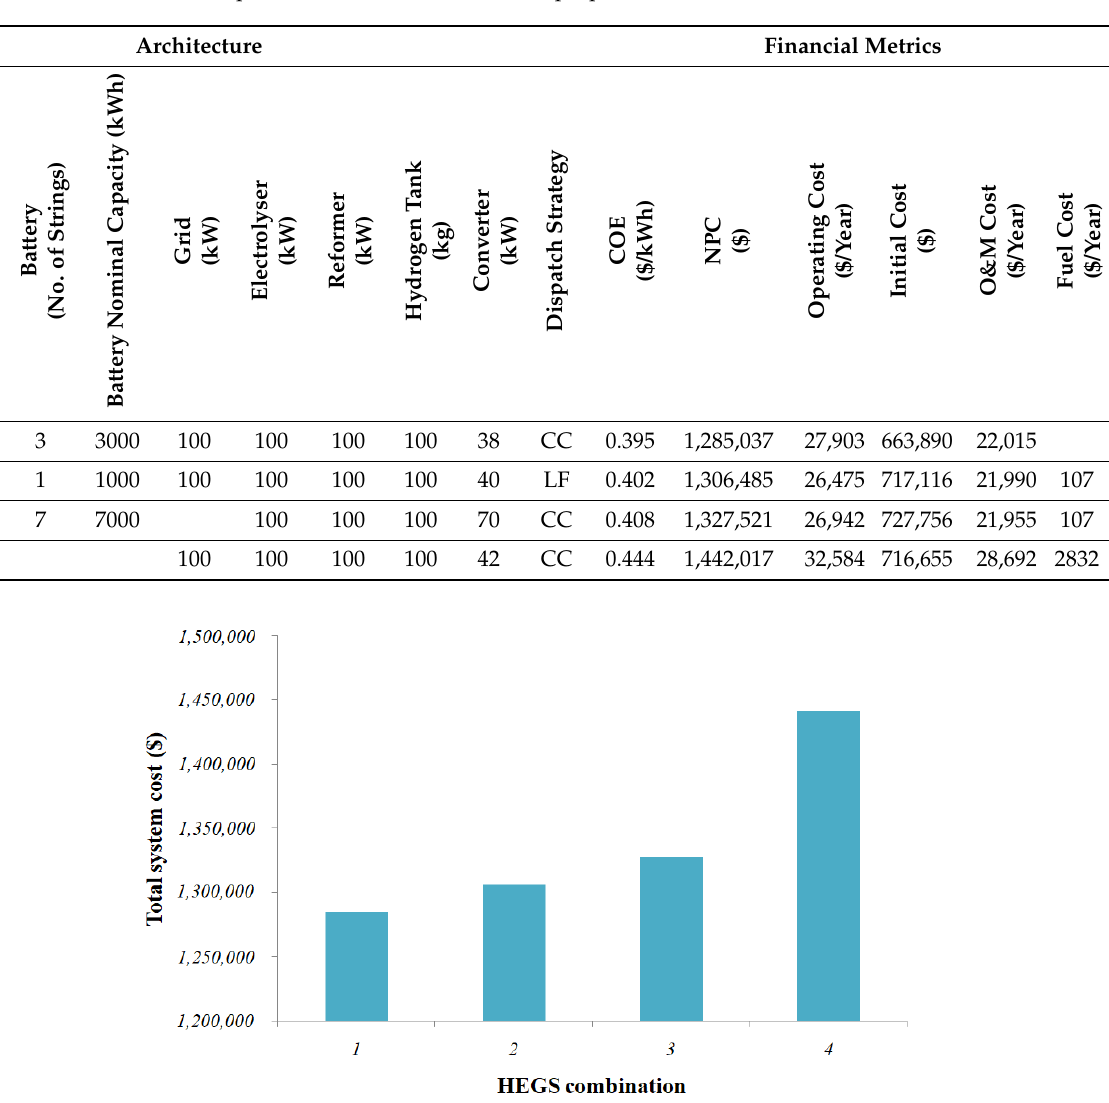
Figure 13. Comparison of cost of energy & cost of hydrogen for selected HEGS combination. 4.2. Technical Analysis The summary of the technical report is provided in Table 6. From a technical point of view, combination 1, 3 & 4 follows the cycle charging (CC) dispatch strategy. In CC strategy, the DG or grid operates at full capacity to serve the load. The excess electricity produced in this case is utilized to charge the battery bank and serve the electrolyser. Combination 2 follows the load ‐ following (LF) strategy. In the LF strategy, the DG or grid operates to generate enough electricity to meet the load demand. The battery bank is charged when a renewable source like a solar PV array generates electricity. The renewable fraction is found to be highest for combination 3, which is 99.8% and the lowest